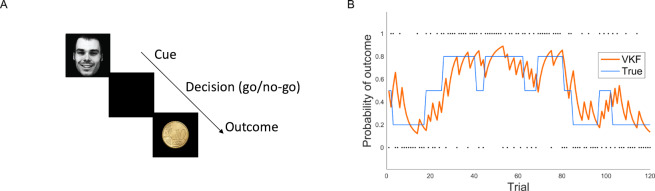
The probabilistic learning task in Experiment 1 used for testing the VKF.A) Participants had to respond (either go or no-go) after a face cue was presented. A probabilistic outcome was presented following a delay. B) An example of the probability sequence of outcome (of a go response) for one of the four trial-types and predictions of the (binary) VKF model. The response-outcome contingencies for the cues were probabilistic and manipulated independently. The dots show actual outcomes seen by the model.